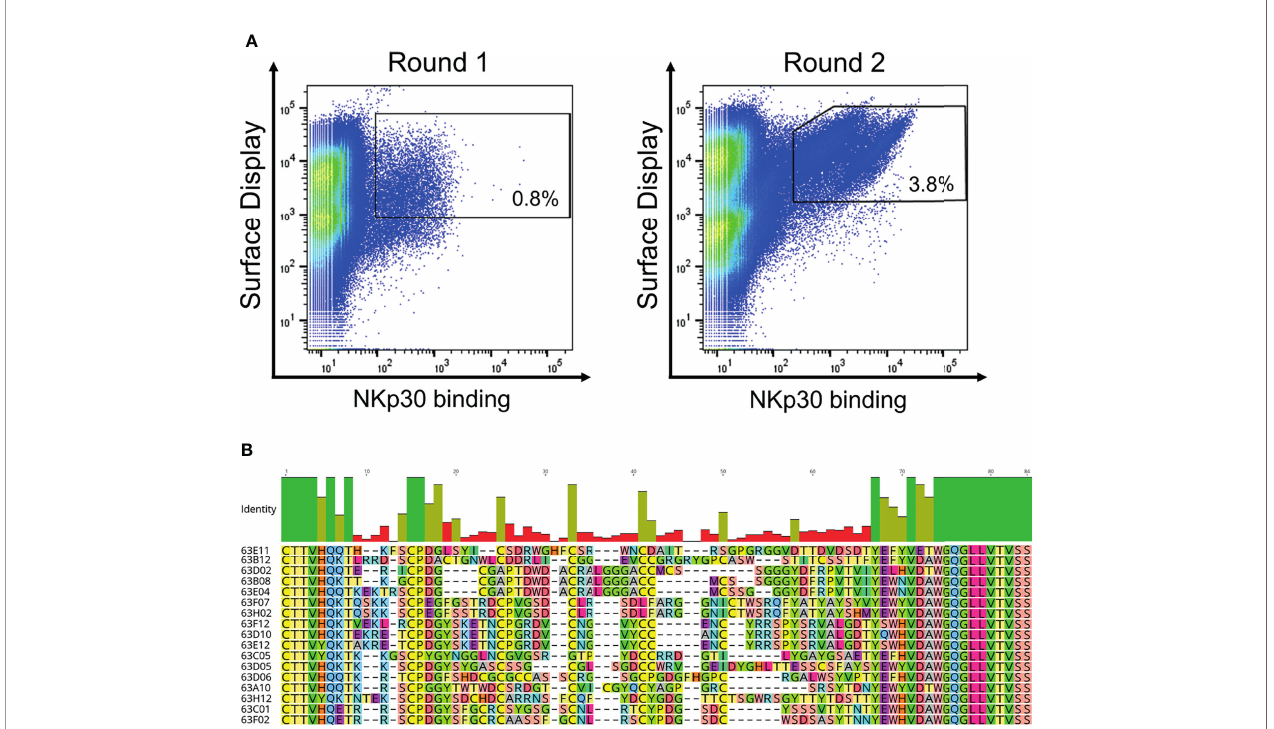
FIGURE 2 | Yeast surface display based selection of NKp30 targeting chimeric bovine x human Fab fragments by yeast surface display as well as sequence analysis after enrichment. (A) Within two sorting rounds a NKp30-binding population was enriched. A two-dimensional sorting strategy was applied to label for functional Fab assembly as well as for NKp30 binding. To this end, library cells were incubated with recombinant human his-tagged NKp30 at a concentration of 1 µM followed by staining using secondary detection reagents directed against the his-tag as well as against the constant region of the human lambda chain. (B) CDR- H3 alignment of sequence unique ultralong CDR-H3 paratopes obtained after library sorting. Sequence of IGHJ2-4 is also shown. Amino acids given in 1-letter code and in different colors. Alignment generated with Geneious Prime ®